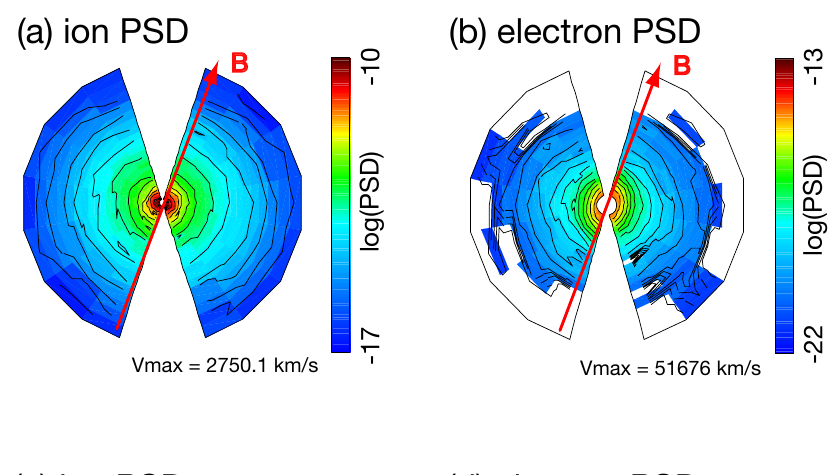
small number of two-component events is due to the lim- ited acquisition of 3-D data and to the seasonal change of the spacecraft orbit. The projection onto the XY ( XZ )